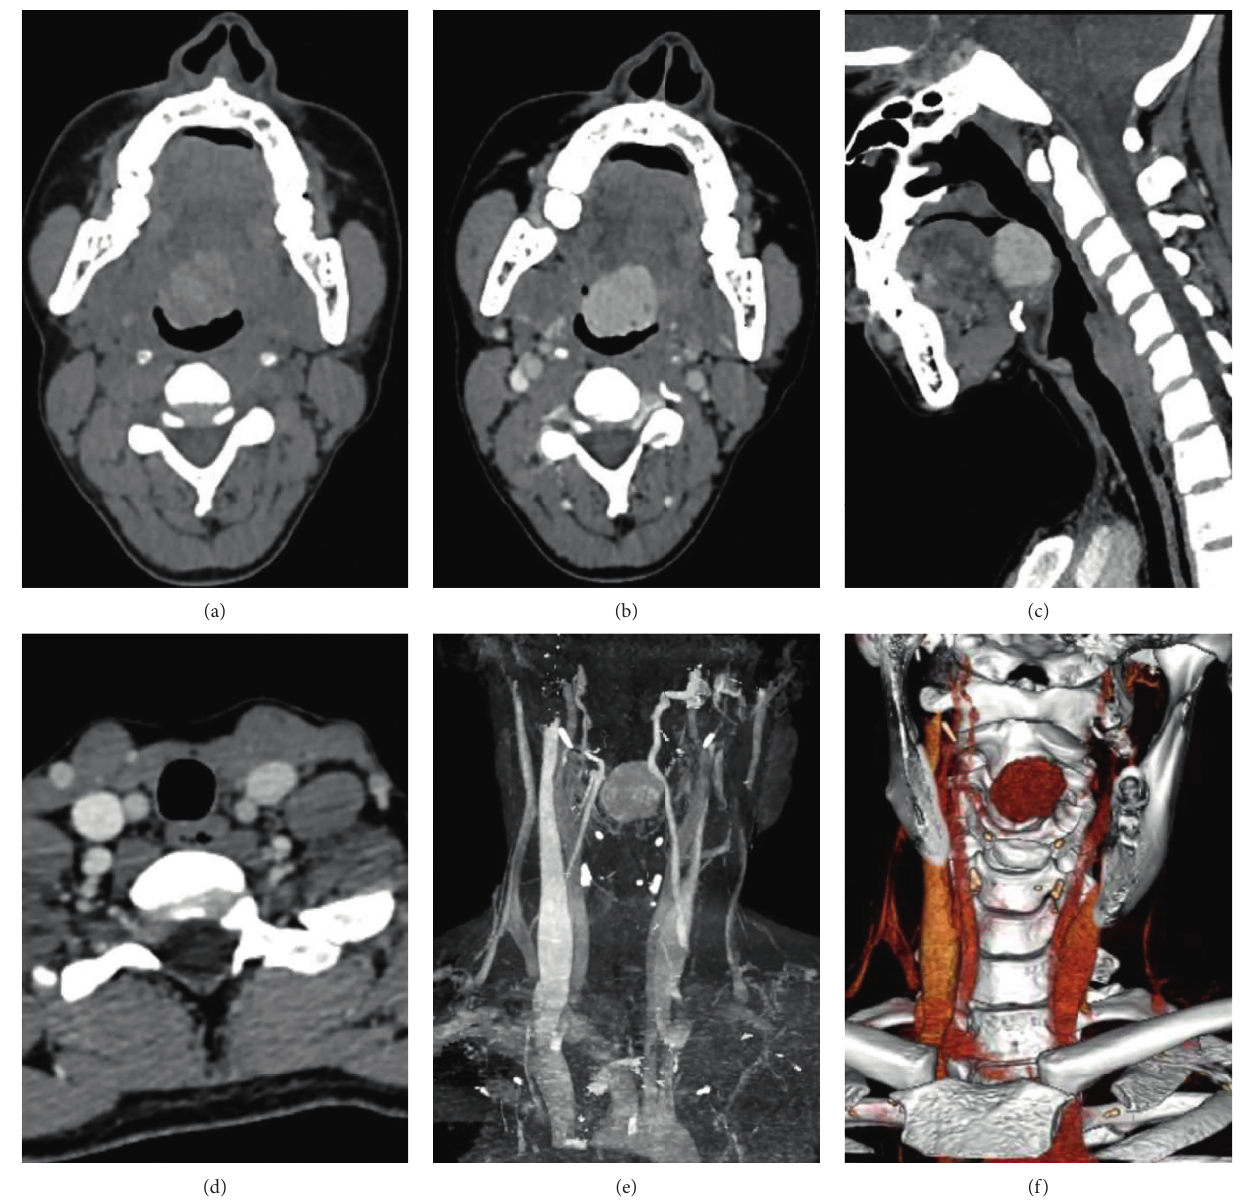
Figure 2: Computed tomography (CT) scan of the neck. Axial noncontrast CTimage with a well-defined relatively hyperdense nodule in the midline at the base of the tongue (a), axial contrast-enhanced CTshowing homogeneous enhancement (b), sagittal contrast-enhanced CT image with an enhancing nodule at the level of C2-C3 vertebra causing narrowing of the oropharyngeal lumen (c), axial contrast-enhanced CT image below the cricoid cartilage without orthotopic thyroid (d), coronal maximum intensity projection (MIP) image with a nodule in the midline (e) with absent orthotopic thyroid, and volume rendered image with a nodule in the midline